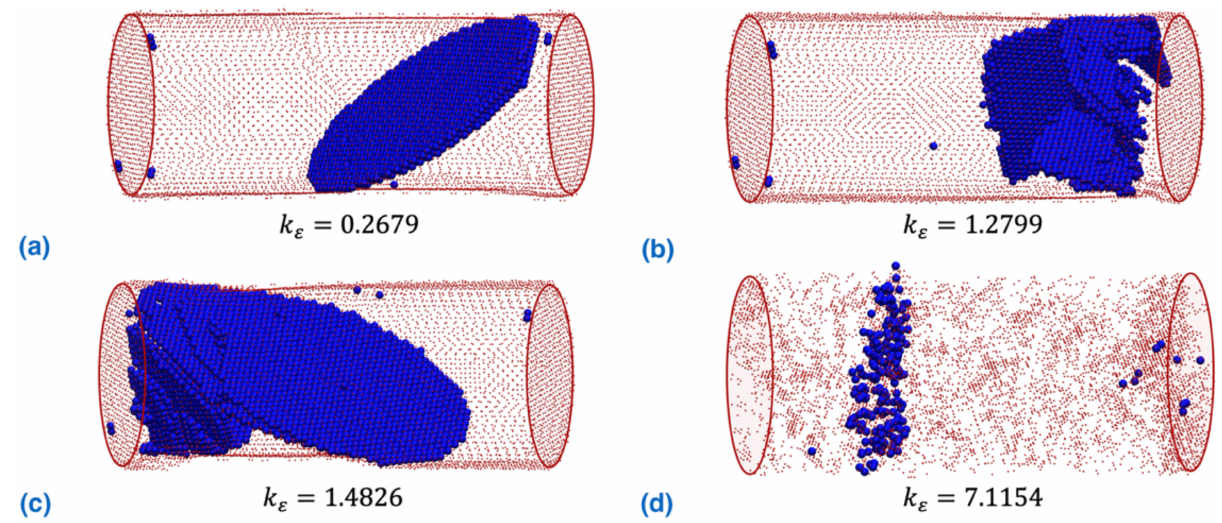
Figure 5. Dislocation patterns of NW after yielding before resumption of stress increase for different torsion/tension strain ratios: ( a ) k ε = 0.2679; ( b ) k ε = 1.2799; ( c ) k ε = 1.4826; ( d ) k ε = 7.1154. Atoms with the Ackland–Jones parameter (AJP) [56] equal to 0 and 3 are visualized in order to identify the atoms in the surface and partial dislocation/stacking faults,